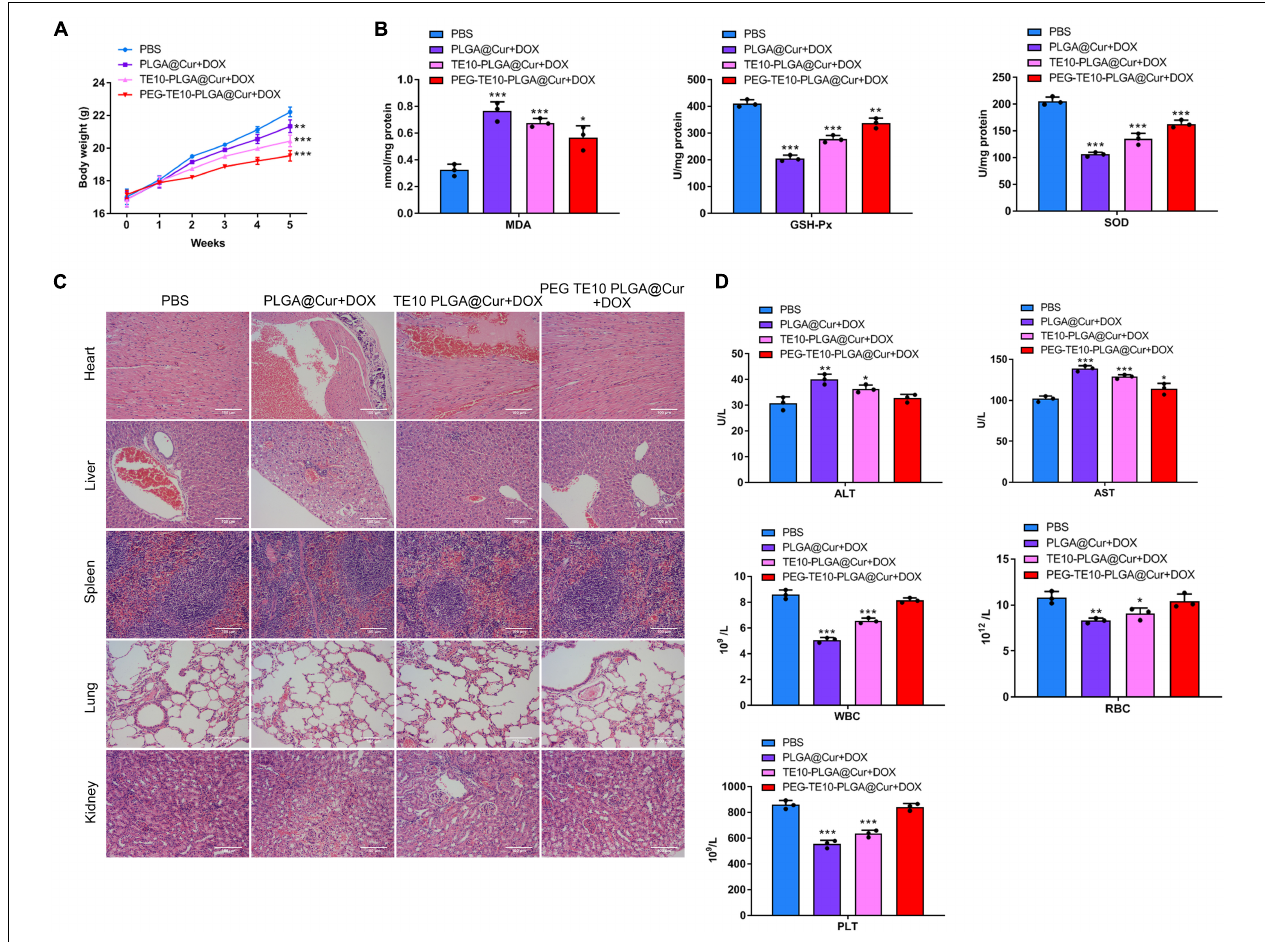
FIGURE 6 | System safety assessment. (A) Body weight changes of mice treated with saline, PLGA@Cur + DOX, TE10-PLGA@Cur + DOX and PEG-TE10-PLGA@Cur + DOX. (B) Detection of the oxidative stress in mouse cardiomyocytes. (C) H&E staining of five major tissue sections of mice. (D) Detection of the concentration of ALT, AST, WBC, RBC, and PLT in the serum of mice. * P < 0.05, ** P < 0.01, *** P < 0.001 vs. control